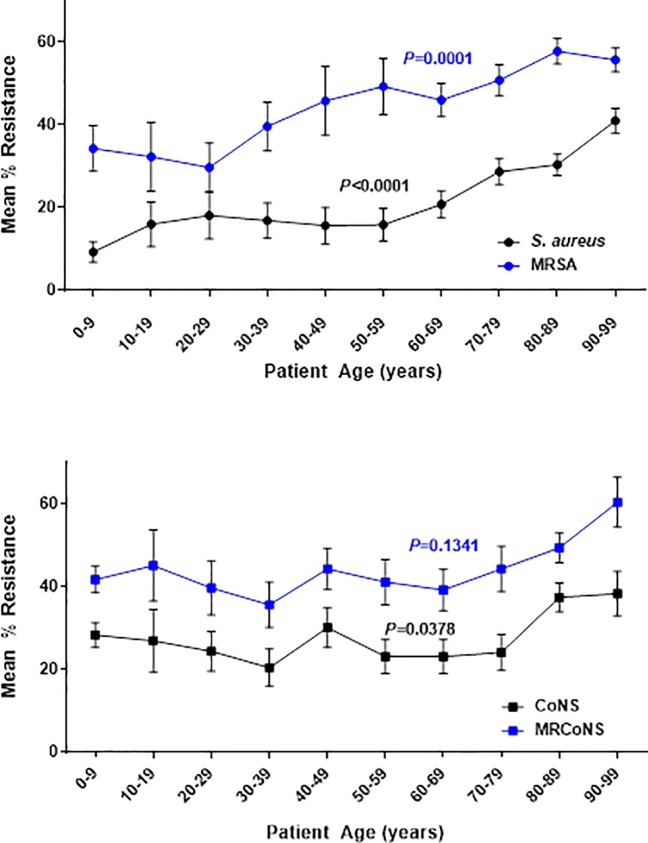
Resistance among staphylococcal isolates from the conjunctiva by patient age.Data are expressed by decade of life for (A) mean ± SE percentage of resistance for S. aureus (black circles) and MRSA (blue circles); (B) mean ± SE percentage of resistance for CoNS (black squares) and MRCoNS (blue squares). P-values are from ANOVAs. Abbreviations: MRSA, methicillin-resistant S. aureus; CoNS, coagulase-negative staphylococci; MRCoNS, methicillin-resistant coagulase-negative staphylococci.